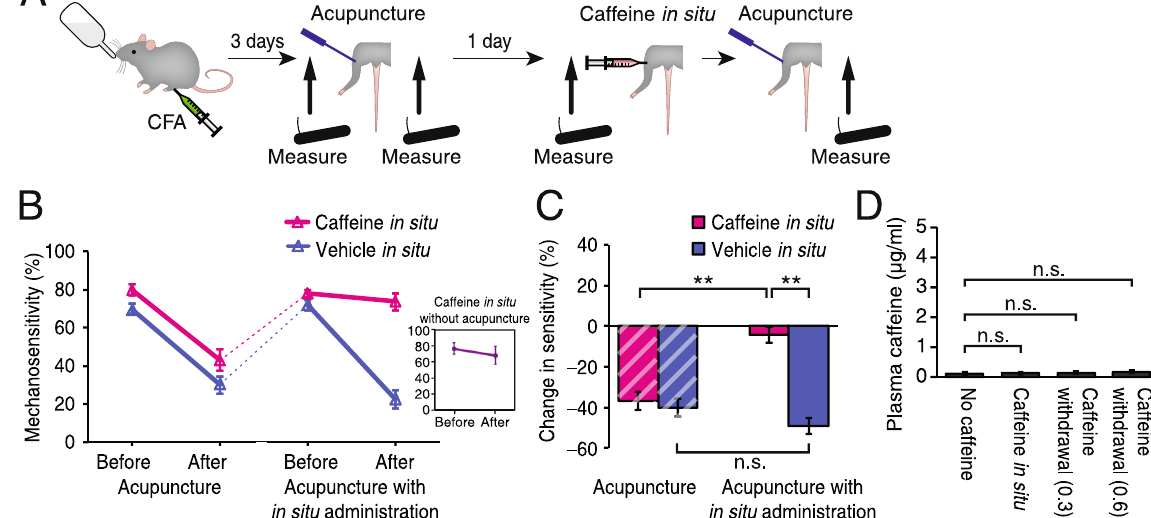
Figure 3. The presence of caffeine at the acupuncture point at the time of acupuncture treatment interferes with the analgesic effects of acupuncture. ( A ) Schematic diagram outlining the two consecutive day behavioral examination and the timing of local caffeine administration. Pain was induced by CFA administration in the ankle joint 3 days prior to the measurements of mechanical sensitivity, before and after acupuncture. On the following day, another set of pain measurements was taken in conjunction with local administration of caffeine (100 µ M, 5 µ l) at the acupuncture point. ( B ) Mechanical sensitivity repeatedly measured on two consecutive days with or without caffeine administration at acupuncture point. Acupuncture reduced mechanical sensitivity in mice without caffeine (Before and After Acupuncture, both magenta and blue lines). Conversely, mechanical sensitivity remained high after acupuncture when caffeine was directly administered at the acupuncture point prior to acupuncture (Caffeine in situ in Acupuncture with in situ administration group, magenta). N = 16. Vehicle administration did not alter the acupuncture-induced analgesia (Vehicle in situ in Acupuncture with in situ administration group, blue). N = 16. Insert : Caffeine in situ administration without acupuncture did not alter mechanosensitivity. N = 8. ( C ) Summary of acupuncture-induced changes in mechanosensitivity shown in panel B. Local administration of caffeine abolished the analgesic effect of acupuncture. ** p < 0.001; n.s., p > 0.1. ( D ) Caffeine in mice plasma under the conditions of no caffeine, 15 min after caffeine administeration at acupuncture point (Caffeine in situ ), or 24 hours after caffeine withdrawal from drinking water (0.3 or 0.6 mg/ ml). N = 15–20; n.s., p > 0.1. Displayed are means ± S.E.M. in B – D